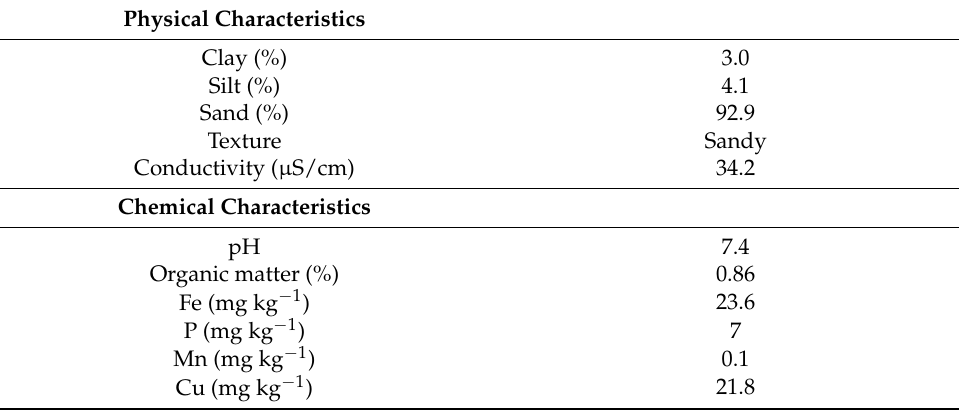
Table 2. Physical and chemical characteristics of the soil.